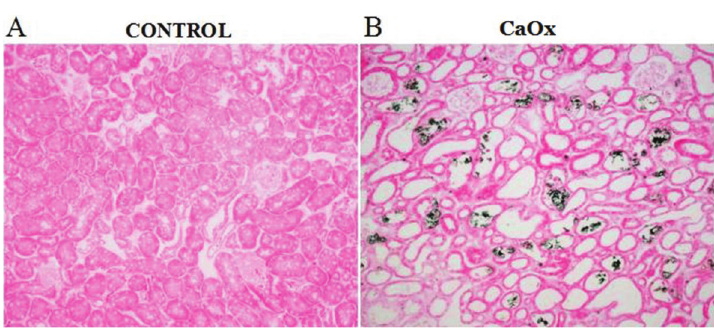
Figure 1. Von Kossa-stained sections of kidneys from mice in the control and experimental groups (experimental group was injected with glyoxylate for 5 days). Signi fi cantly higher calcium oxalate (CaOx) deposition was observed in the experi- mental group ( B ) than in the control group ( A ). Magni fi cation: 200 (cid:1)